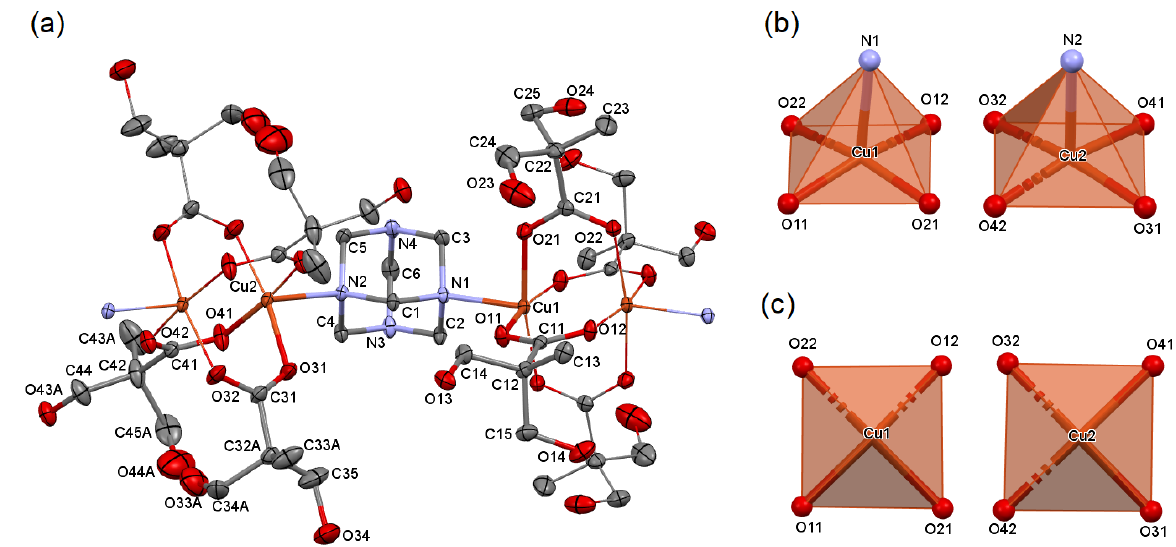
Figure 3. Molecular structure of 3, plotted with a 50% probability of displacement ellipsoids of nonhydrogen atoms ( a ). The equivalent atoms (without labels) were generated according to transformations: − x , − y , − z and − x + 1, − y + 1, − z + 1. Hydrogen atoms and parts with distorted dmp anions of lower contribution were omitted for clarity. Coordination polyhedra of 3, general view ( b ), tetragonal bases ( c ).